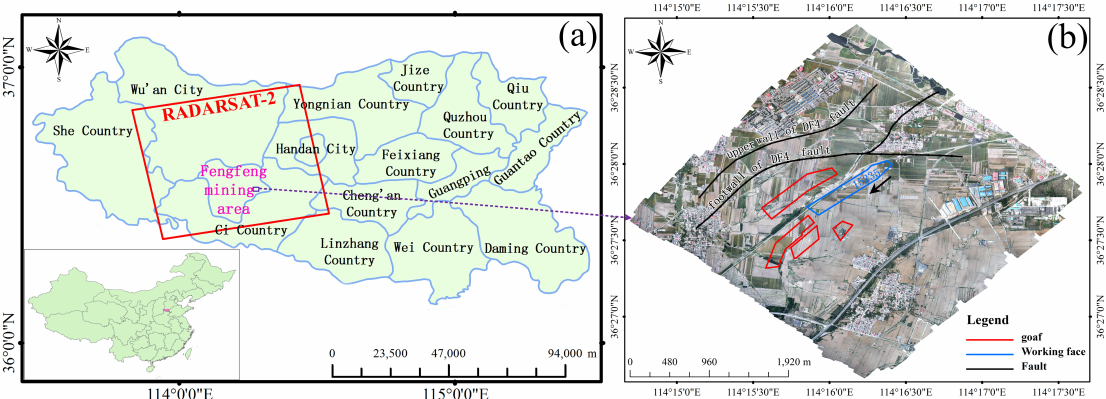
Figure 9. Study area overview. Figure ( a ) shows the location of the study area and the coverage of RADARSAT-2 images in the study area. In Figure ( b ), the black arrow indicates the mining direction, and the base map is spliced by UAV images that have a 0.8 m